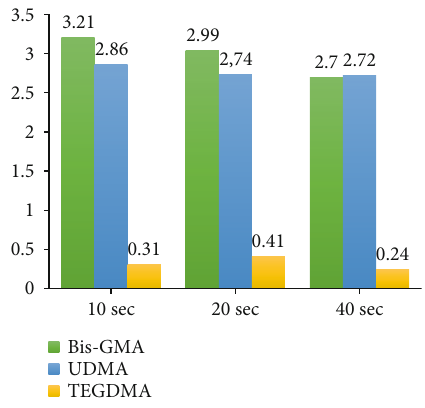
Figure 1: The total amount of residual monomers released. ∗∗ Unit of all released monomers ’ volume is in ppm. 1 ppm = 0 : 001mg/mL .